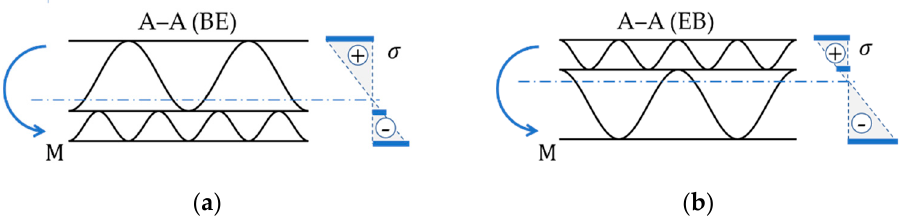
Figure 2. Two possibilities of placing the corrugated board in the 4-point bending test: ( a ) B-flute upwards (BE); ( b ) E-flute upwards (EB).